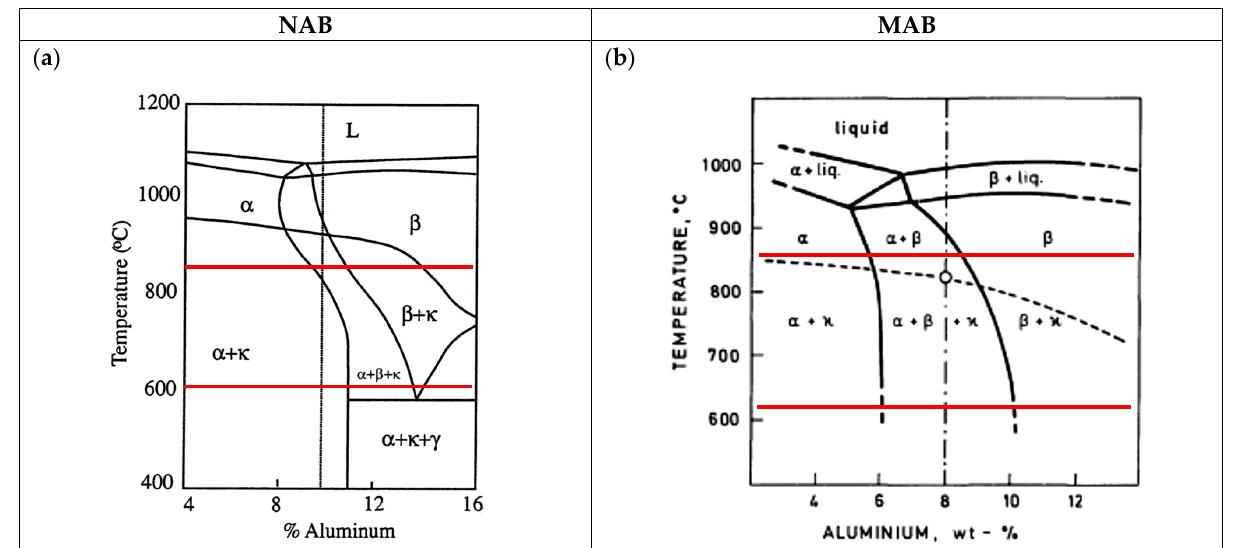
Figure 1. Partial phase diagrams of CuAl10Fe5Ni5 type of NAB alloy [10] and CuMn12Al8Fe4Ni2 type of MAB alloy [18] showing in red colour the temperatures of the respective heat treatments applied in this investigation. ( a ) NAB; ( b ) MAB.